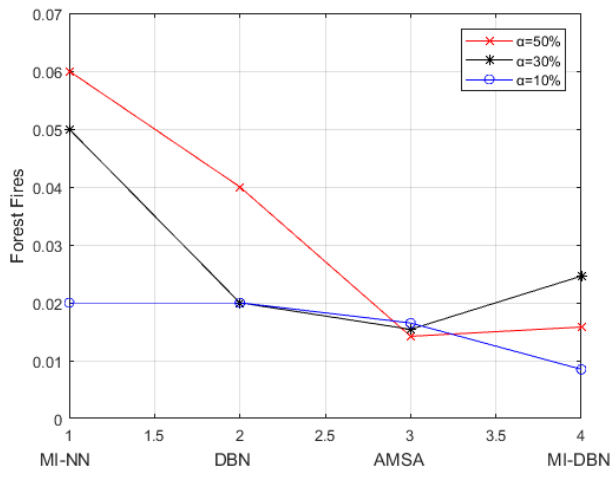
Figure 6. Improvements over previous methods.